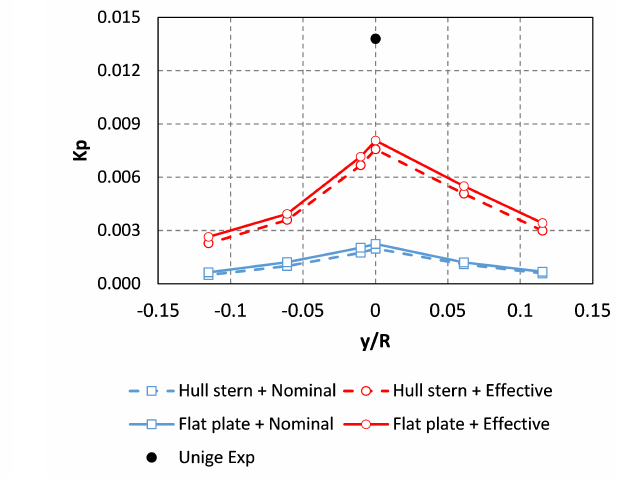
Figure A.3: Effect of the hull shape and of nominal and effective wakes in correspondence of different transversal point at longitudi- nal propeller plane position. Fourth harmonic values.